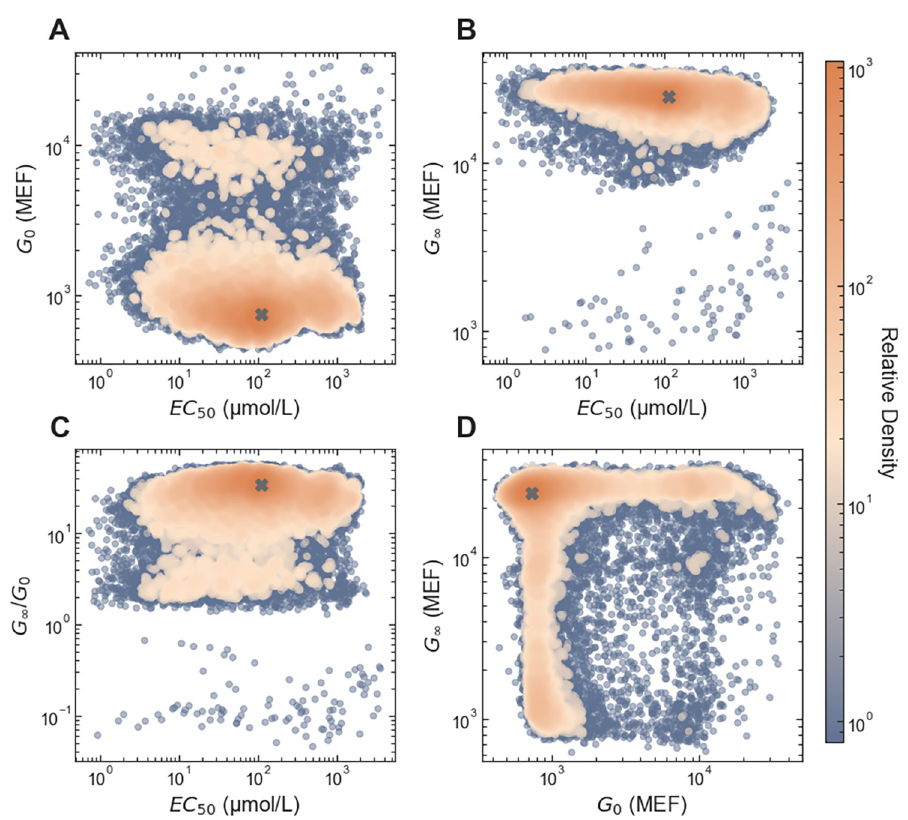
Fig 1. Diversity of dose-response phenotypes in the large-scale dataset. The colored points are the values as reported in the genotype-phenotype dataset, with colors indicating the relative density of similar phenotypes. The gray ‘X’ in each plot shows the parameter values for the wild-type LacI dose-response